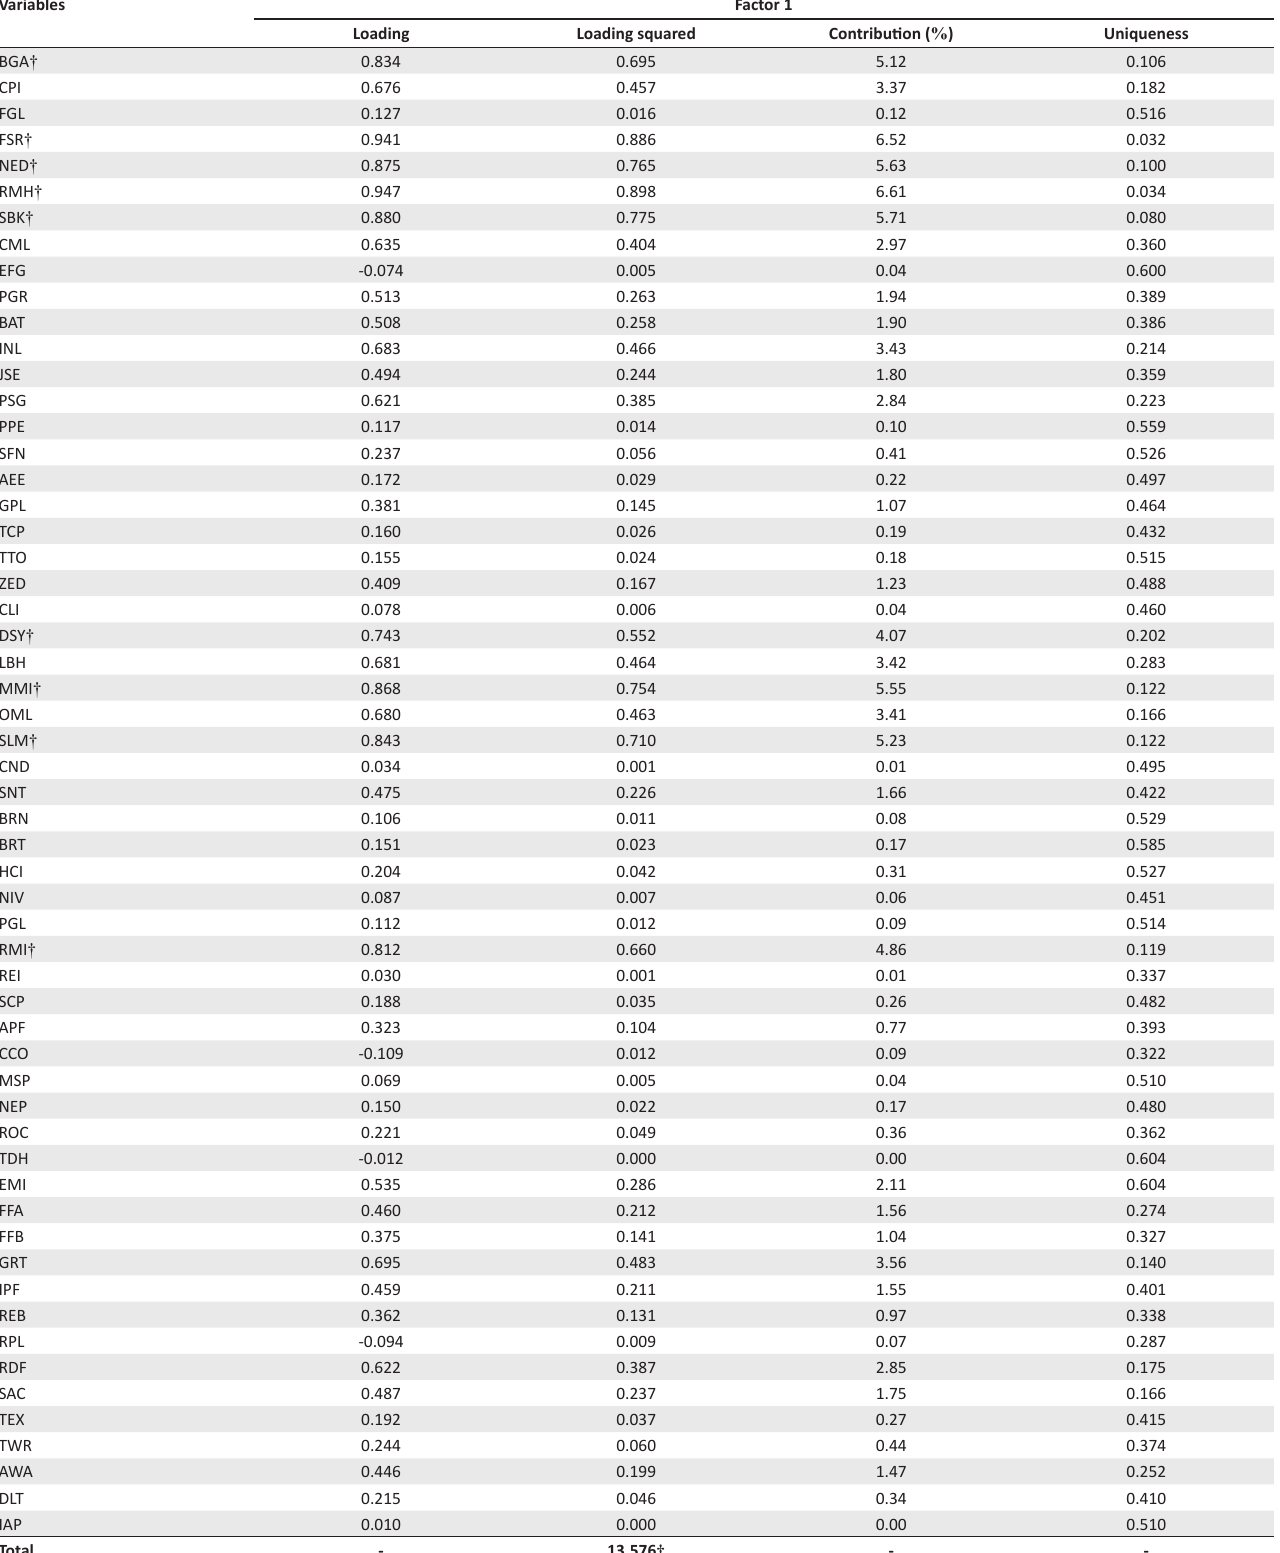
TABLE 2: Contribution to factor variance: Three-year time horizon.